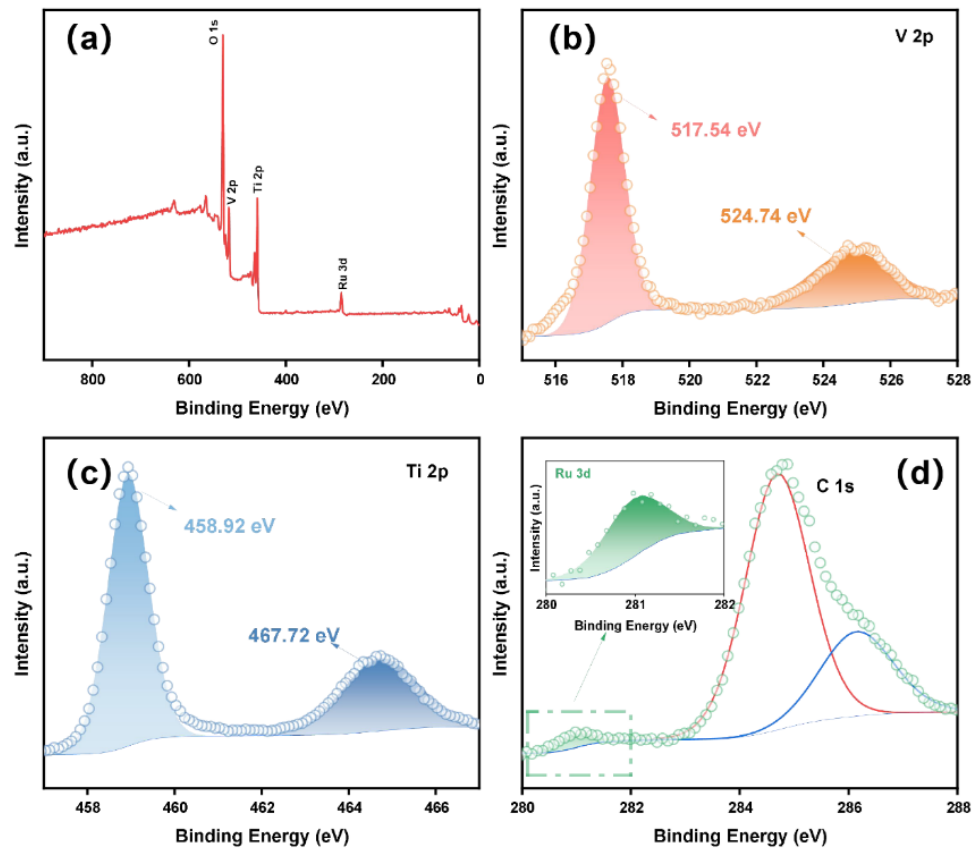
Figure 2. ( a ) The XPS survey spectra of Ru-VTO. ( b – d ) XPS spectra of V 2p, Ti 2p and Ru 3d in the initial state. Cyclic voltammetry was used to examine the sodium storage behavior of Ru-VTO (CV). The strong cathodic peaks at about 1.1 V and 1.8 V disappeared after the initial scan, as is shown in Figure 3a, which was ascribed to solid electrolyte interphase (SEI) layer development and irreversible sodium intercalation [41,42]. A couple of reduction/oxida- tion peaks (0.913/0.690 V) wi th a peak deviation (ΔE) of 0.223 V were visible following the preliminary scan of the almost-overlapping CV curves of Ru-VTO, which contrasted well with that of VTO (∆E: 0.424 V) (Figure S6). The enhanced electronic conductivity and dif- fusion kinetics brought about through Ru-doping were likely responsible for the de- creased overpotential of Ru-VTO. Figure 3b shows the first charge/discharge curves of Ru-VTO and VTO at 50 mA g −1 . Galvanostatic charge and discharge voltage profiles of Ru-VTO and VTO under different current densities are seen in Figure S5a,b. The SEI layers and certain secondary reactions (irreversible reactions) between electrolyte and electrodes were observed to coincide with a bright outflow plateau with a slope extending from 1.31 to 0.9 V [43 – 46]. The original discharge/charge ratio capacity of Ru-VTO and VTO anodes was 602/303 and 600/244 mAh g −1 , corresponding to the initial Coulomb efficiency of 50.3% and 40.6%. The irreversible breakdown of the electrolyte, the restricted reversibility